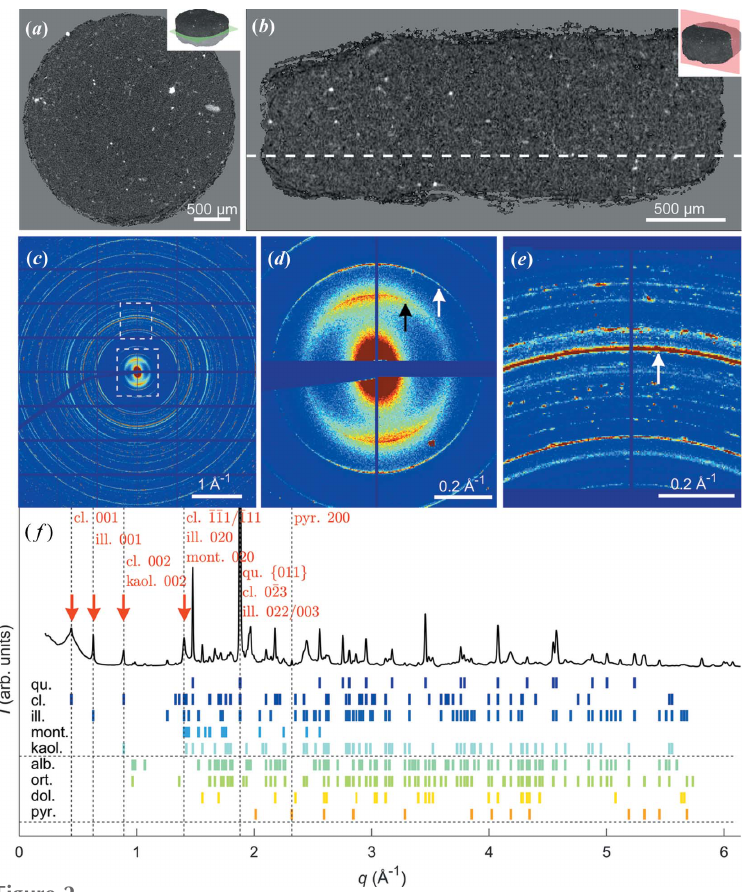
Figure 2 An overview of the Pierre shale sample. ( a ), ( b ) Orthogonal attenuation-contrast CT cross sections. ( c ) A single diffraction pattern obtained from the sample centre with insets shown in ( d ) and ( e ). There is strong texture in the clinochlore 001 and illite 001 peaks, marked with black and white arrows, respectively, in ( d ). The white arrow in ( e ) points to the overlapping Bragg peaks of quartz {011}, clinochlore 0 (cid:5) 223 and illite 022/003. The grid and the missing data are due to detector panel gaps and the beam stop. ( f ) An indexed diffractogram revealing the sample composition. The low- q Bragg peaks marked with red arrows all display pronounced texture. The intense overlapping peaks of quartz {011}, clinochlore 0 (cid:5) 223 and illite 022/003 have been cut in ( f ) for display purposes. Abbreviations: qu., quartz; cl., clinochlore; ill., illite; mont., montmorillonite; kaol., kaolinite; alb., albite; ort., orthoclase; dol., dolomite; and pyr.,